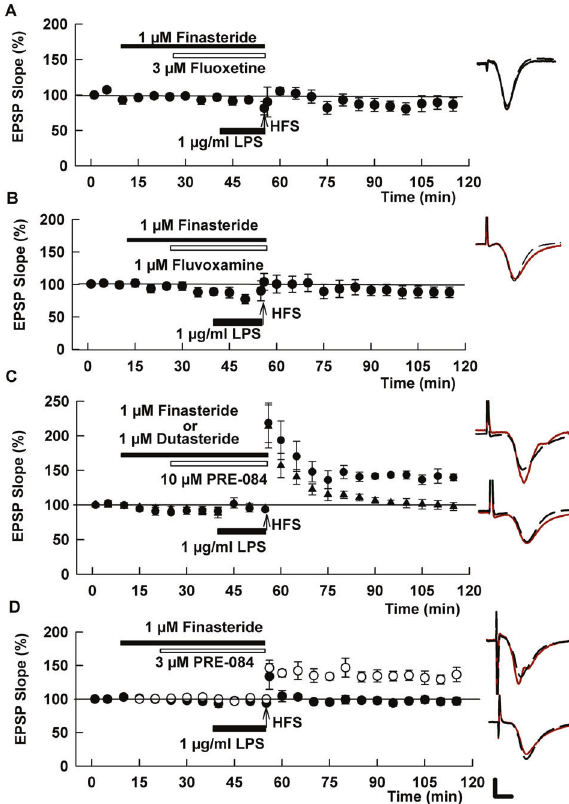
Fig. 4 Effects of fl uoxetine and fl uvoxamine on LPS require synthesis of 5-alpha reduced neurosteroids. A The 5AR antagonist, fi nasteride, which inhibits the synthesis of 5-alpha-reduced neuro- steroids, completely blocked the effects of fl uoxetine on LPS. B Similar to fl uoxetine, fi nasteride also overcame the effects of fl uvoxamine on LPS. C In contrast to the SSRIs, fi nasteride did not overcome the effects of the S1R agonist, PRE-084, on LPS (black circles). However, a broader spectrum 5AR inhibitor, dutasteride (black triangles), prevented the ability of PRE-084 to promote LTP in the presence of LPS. D An intermediate concentration of PRE-084 (3 μ M, white circles)) overcame the effects of LPS and was reversed by fi nasteride (black circles), akin to the SSRIs. Traces show representative EPSPs. Calibration: 1 mV, 5 ms.